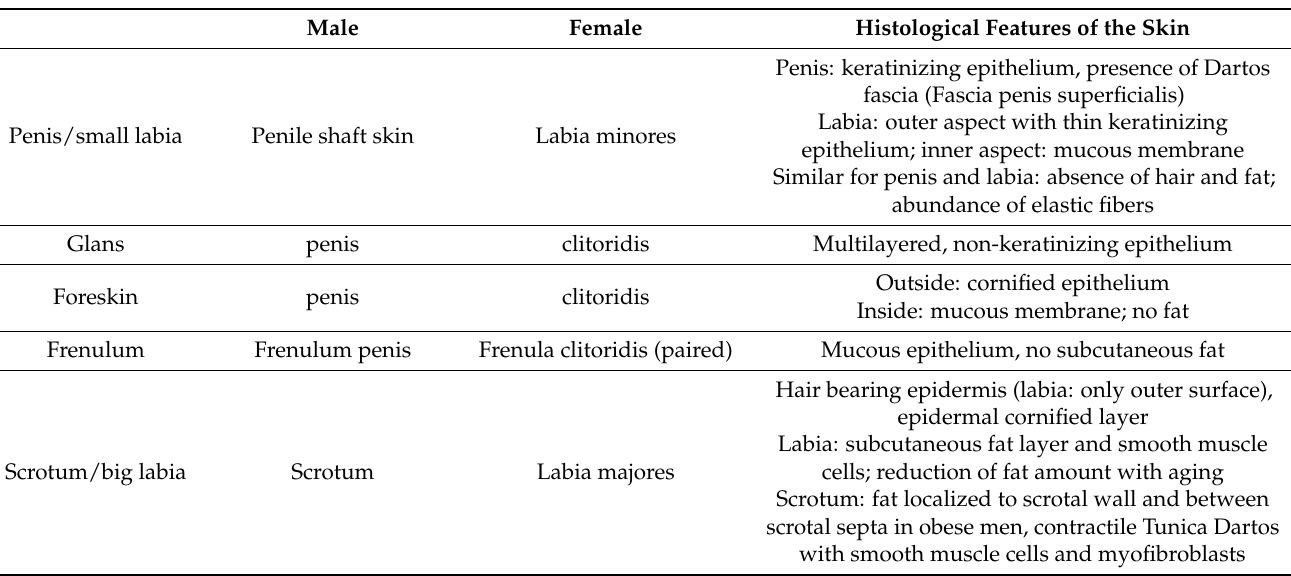
Table 1. Skin structure of homologous male and female outer genitalia (modified after Mirastschi- jski et al. [11]).